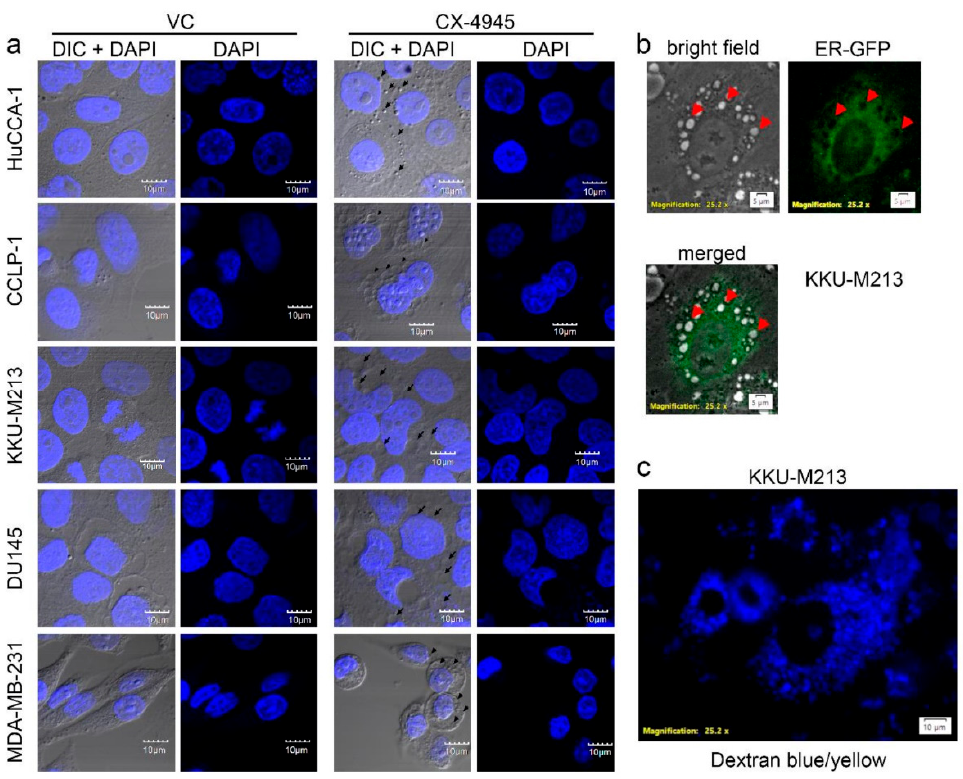
Figure 6. CX-4945 induced methuosis in CCA cell line, KKU-M213. ( a ) CX-4945 induced cytoplasmic vacuolization in three CCA cell lines (HuCCA-1, CCLP-1, and KKU-M213) prostate cancer cell line (DU145), and breast cancer cell line (MDA-MB-231), while it left the nucleus intact as compared to the vehicle control group. ( b ) The endoplasmic reticulum (ER) of KKU-M213 showed no sign of swelling during vacuolization induced by CX-4945. ( c ) The vacuoles induced by CX-4945 contained dextran blue/yellow, which was added in the culture media during CX-4945 incubation. The presence of dextran blue/yellow in the vacuoles indicated that cell engulfed extracellular fluid and formed vacuoles. VC; vehicle control, arrow head indicates cytoplasmic